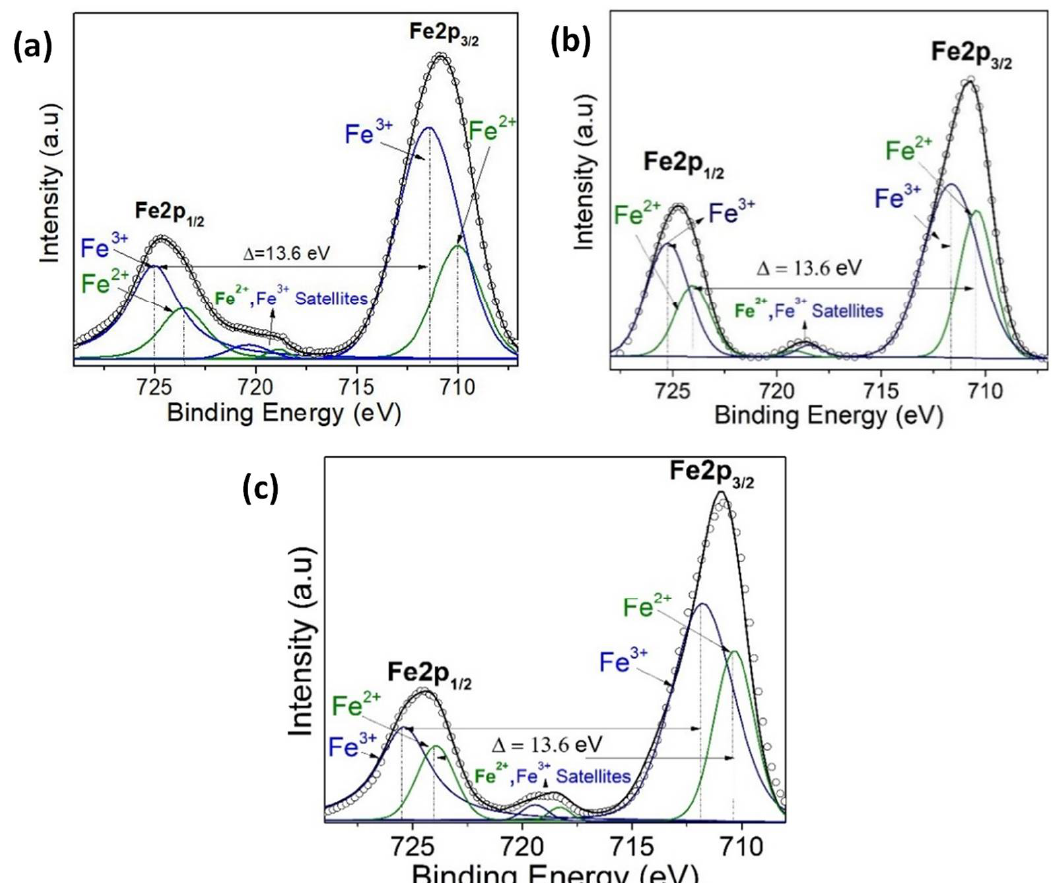
Figure 10. ( a ) XPS narrow scan of Fe 2p signals for ( a ) BFO/SrTiO 3 , ( b ) BFO/VO 2 /Al 2 O 3 with a BFO of 30 nm, and ( c ) BFO/VO 2 /Al 2 O 3 with a BFO of 60 nm.